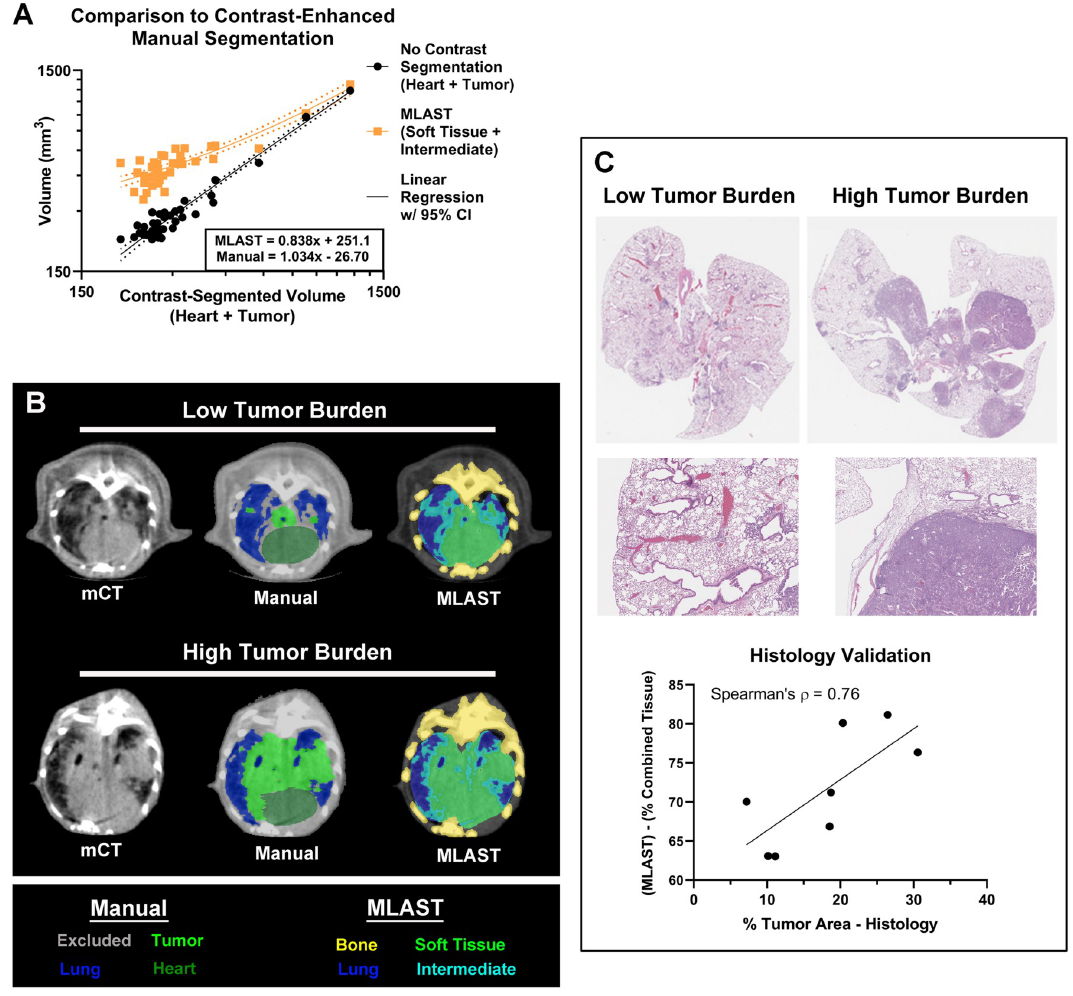
Fig 5. Comparison of MLAST using contrast-enhanced microCT imaging and histology. (A) Validation results showing linear regression of MLAST and manually segmented volumes vs contrast-enhanced manual segmentation on a log scale. The volumes of MLAST-segmented non-contrast scans, which are made up of soft tissue and intermediate, are shown in orange. The volumes of manually segmented non-contrast scans, which are made up of heart and tumor, are shown in black. The x-axis represents the volumes of manually segmented contrast-enhanced scans, which are also made up of heart and tumor. Regression lines (solid) are shown for both results, along with a 95% Confidence Interval (dotted). (B) Representative scans with low and high tumor burden by manual and MLAST segmentation. (C) MLAST validation with histology: Representative H&E stained images with low and high tumor burden at low and high magnification. The graph shows the correlation of tumor burden evaluation by MLAST to H&E methods.